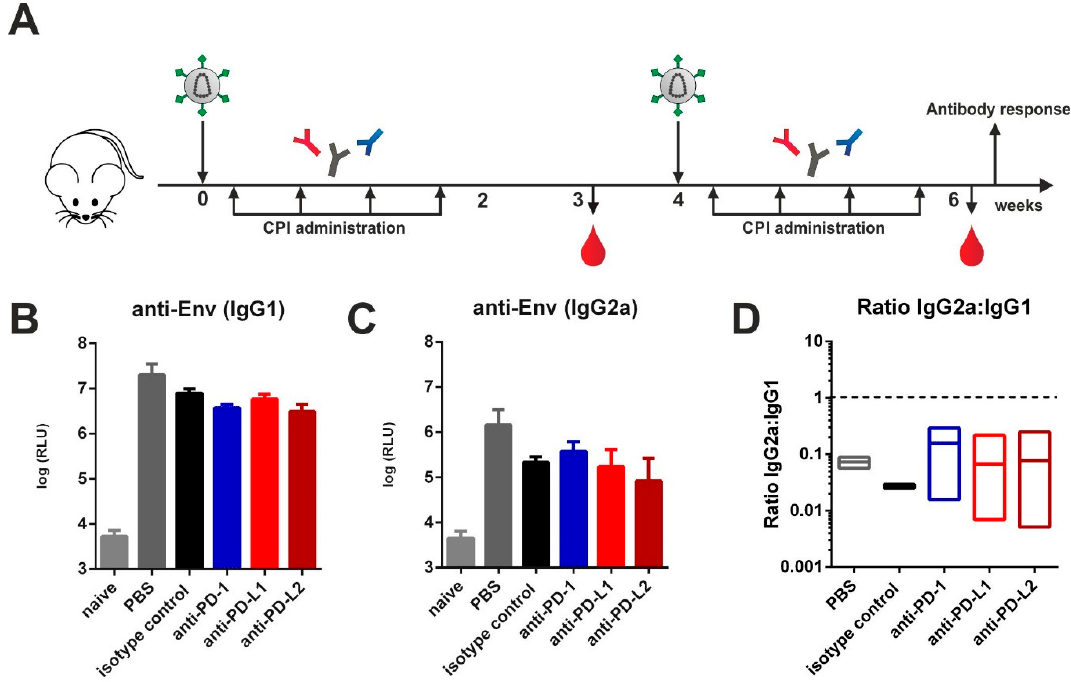
Figure 1. Checkpoint inhibition by monoclonal antibody administration after virus-like particle (VLP) immunization. ( A ) Six-week old BALB/c mice were intramuscularly immunized with VLPs containing Env and Gag. Two days after immunization, 200 µg of checkpoint inhibitors (CPIs) or isotype control were administered intraperitoneally in three-day intervals over a total time-period of two weeks. Animals received a booster immunization with a follow-up CPI administration that was identical to the priming regimen. Blood was drawn at weeks 3 and 6 and antibody responses analyzed. Env-specific IgG1 ( B ) and IgG2a ( C ) antibody responses and IgG2a:IgG1 ratios ( D ) in the sera of BALB/c mice six weeks after priming. Shown are mean values with standard errors of the means (SEM) ( n = 4 for experimental groups, n = 2 for controls (naïve, PBS)).